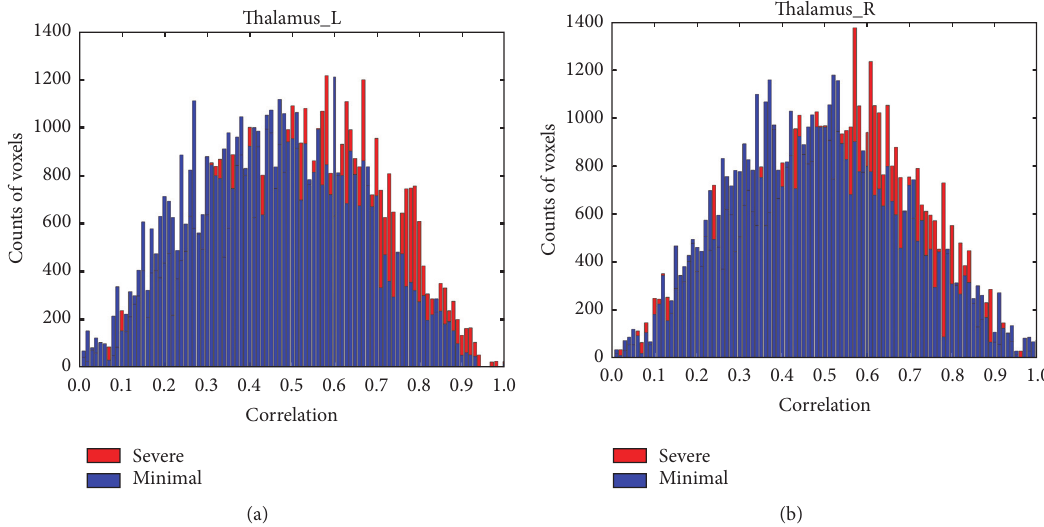
Figure 5: Comparisons of histogram plots of correlation coefficients over all subjects in bilateral thalamus. Blue bins = data for minimal fatigue stage. Red bins = data for significant fatigue stage. Voxels with very low correlation (𝑟 < 0.001) were excluded for better visualization of coefficient distribution of the voxels in each ROI. More voxels (red bins) can be found in the significant fatigue stage to have higher correlation (FC with seed area) values in low-to-high correlation range in bilateral thalamus ROIs.